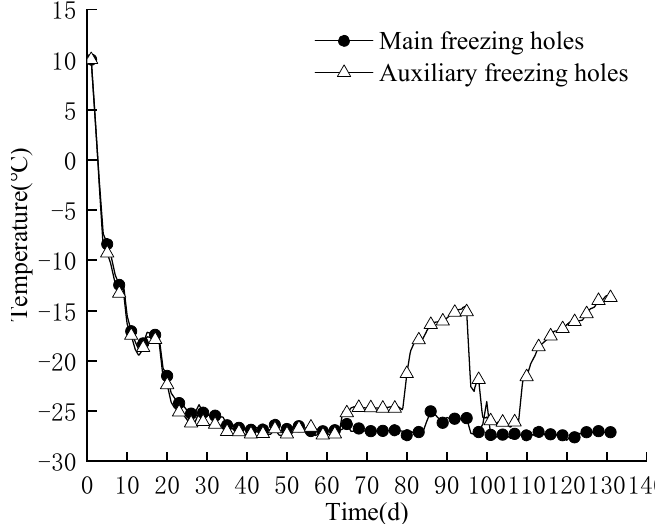
Figure 3. Measured brine temperature.